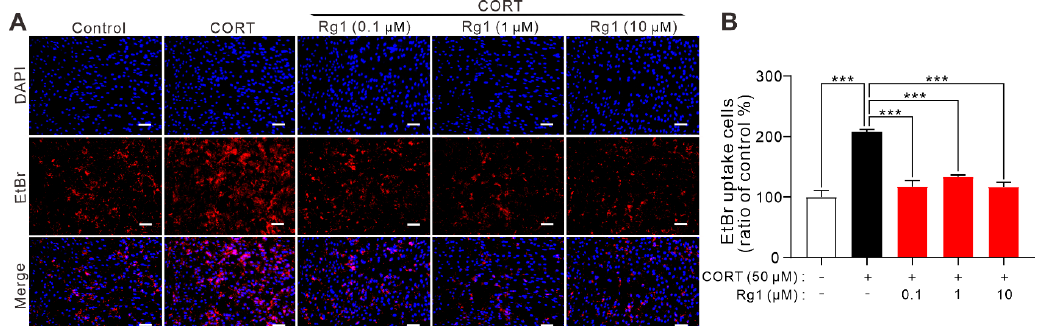
Figure 3. Rg1 inhibited the opening of hemichannels in astrocytes induced by CORT. ( A ) Representative images describing EtBr uptake via hemichannels in each group. Red fluorescence indicates EtBr-positive astrocytes. Blue fluorescence indicates nuclei. ( B ) The ratio of EtBr-positive cells to nuclei represents the degree of EtBr uptake in astrocytes. CORT treatment increased astrocytic EtBr uptake, and all three concentrations of Rg1 (0.1, 1, and 10 µM) pretreatment reversed the effect. All data are shown as mean ± SEM ( n = 3). Scar bar: 75 µm. *** p < 0.001. CORT, corticosterone; EtBr, Ethidium bromide.